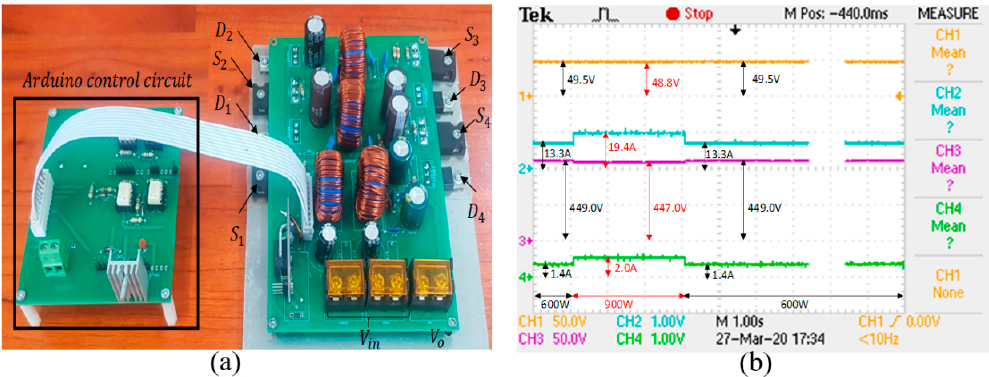
Figure 7. Experimental model ( a ), the input / output voltage and current in the experiment, ( b ) input voltage: orange, output voltage: violet, input current: cyan and output current: green.